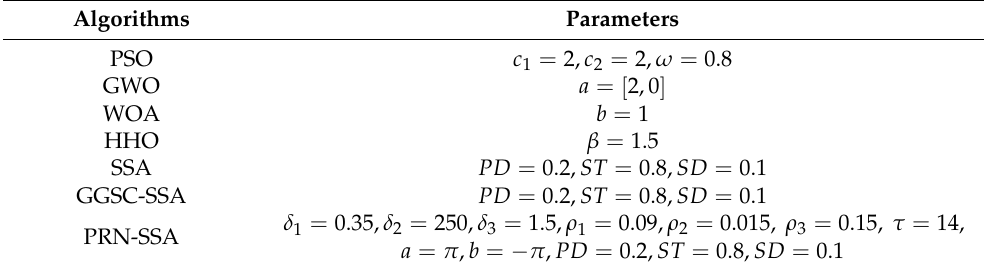
Table 3. Internal parameter settings of each algorithm. Algorithms